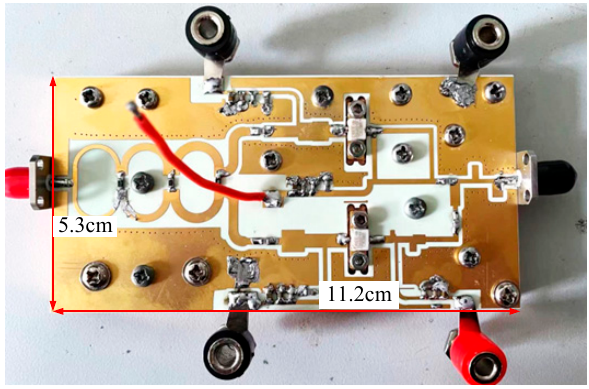
Figure 16. Photograph of the designed DPA.